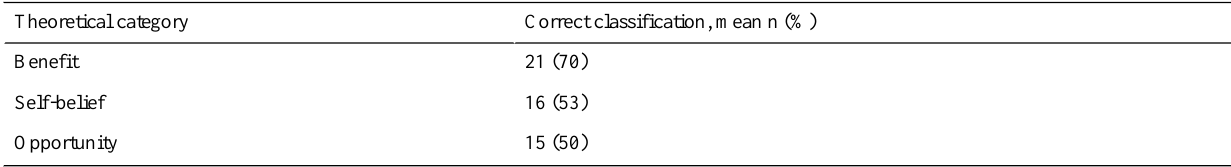
Table 3. Amazon Mechanical Turk classification results of messages by theoretical category